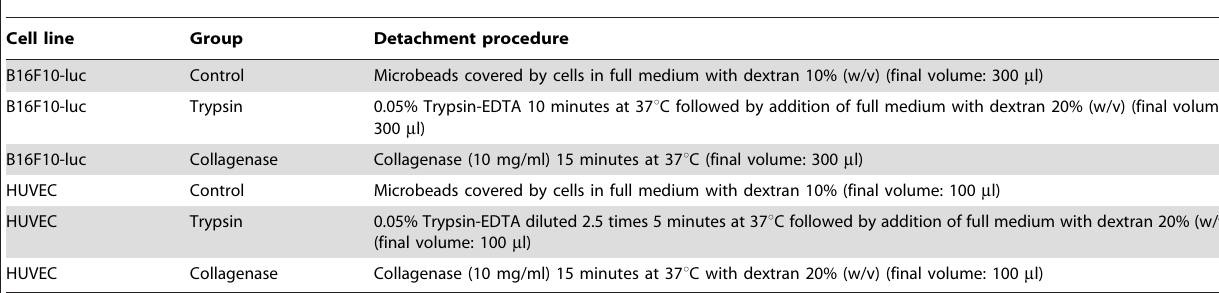
Table 1. Summary of the different experimental conditions.